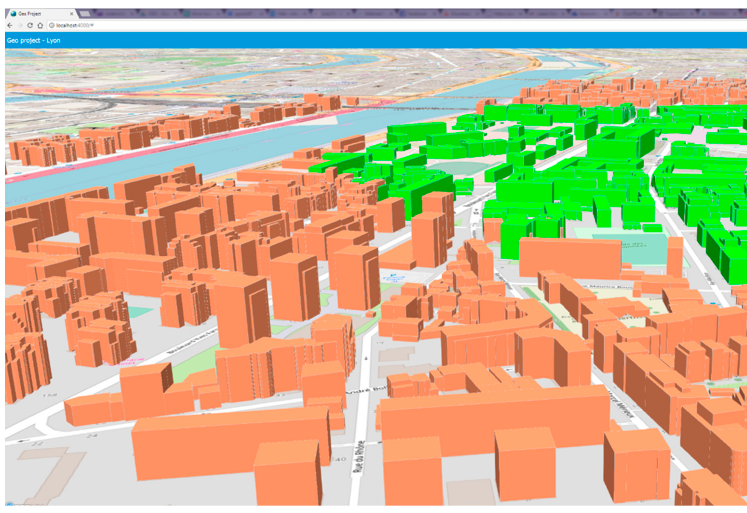
Figure 1. Visualization of a geoquery by the proposed